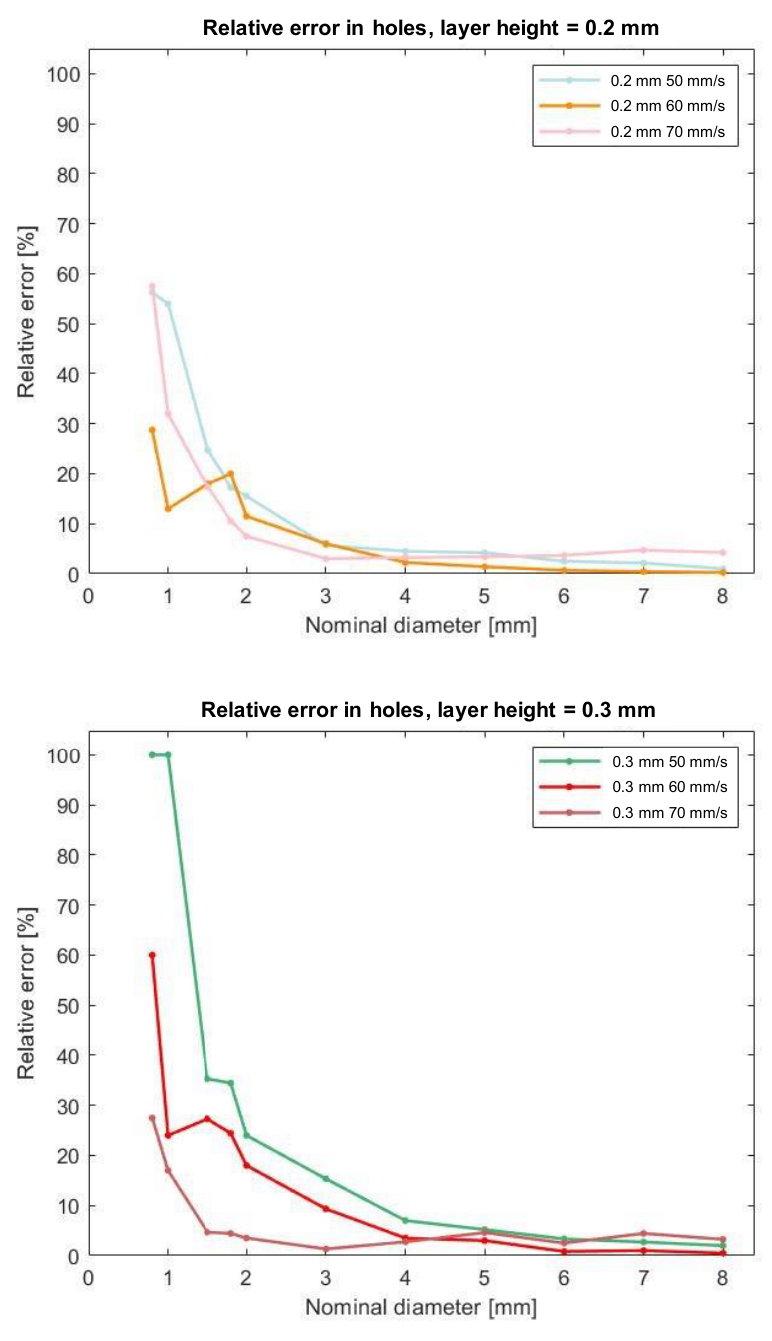
Figure 6. Relative error in holes as a function of the nominal diameter for a fixed layer height, varying three different printing speeds.